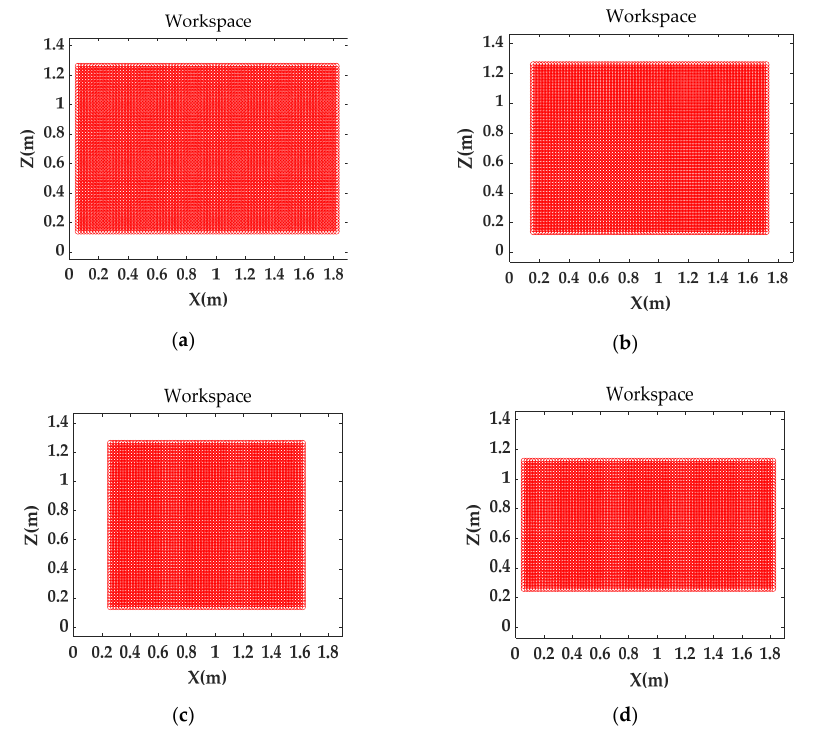
Figure 5. Simulation results when the rotation angle is 0°: ( a ) 1# simulation results; ( b ) 2# simulation results; ( c ) 3# simulation results; ( d ) 4# simulation results.